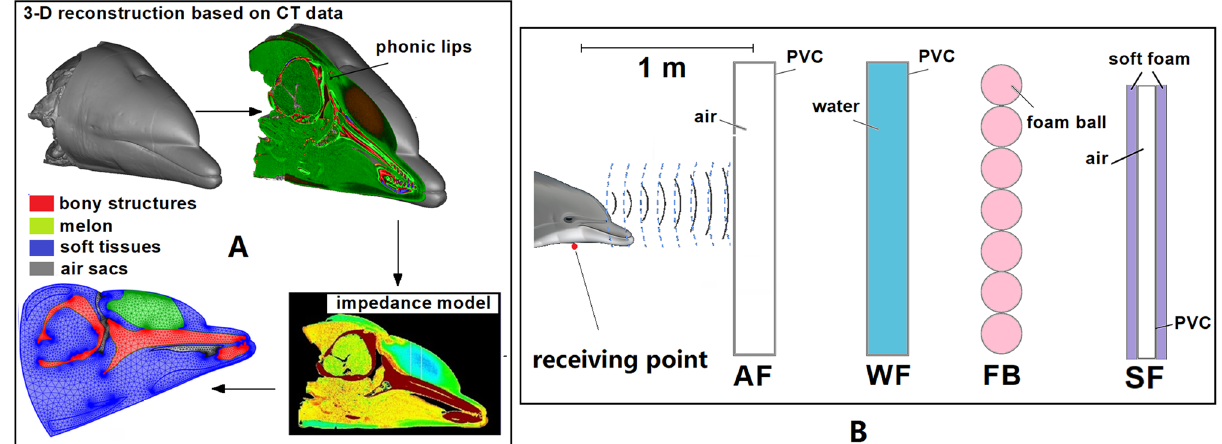
Figure 6. The reconstruction of four FE models. ( A ) The impedance model was reconstructed based on a slice cut through the phonic lips in the vertical plane from high-resolution CT data. The impedance model was imported into the FE software for meshing. ( B ) The FE models were used to simulate a bottlenose dolphin discriminating four 2D representation of cylindrical-shaped targets. The red dot is the receiving point close to the lower jaw of the dolphin.